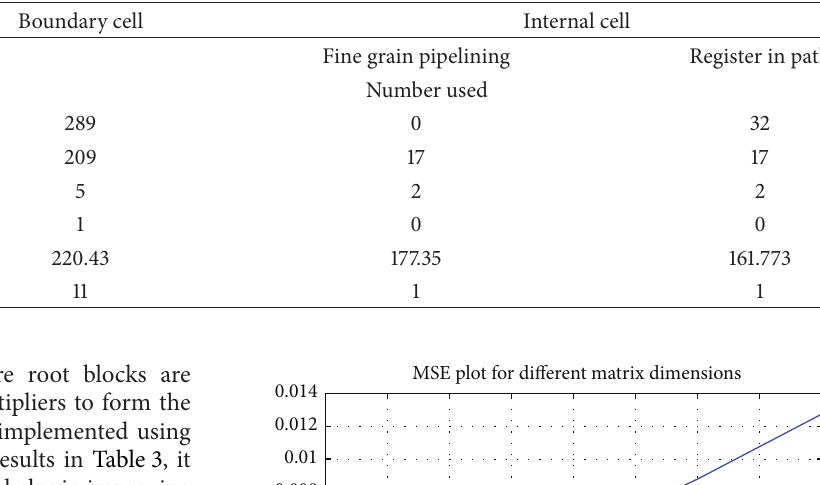
Table 3: Implementation results for the processing elements.